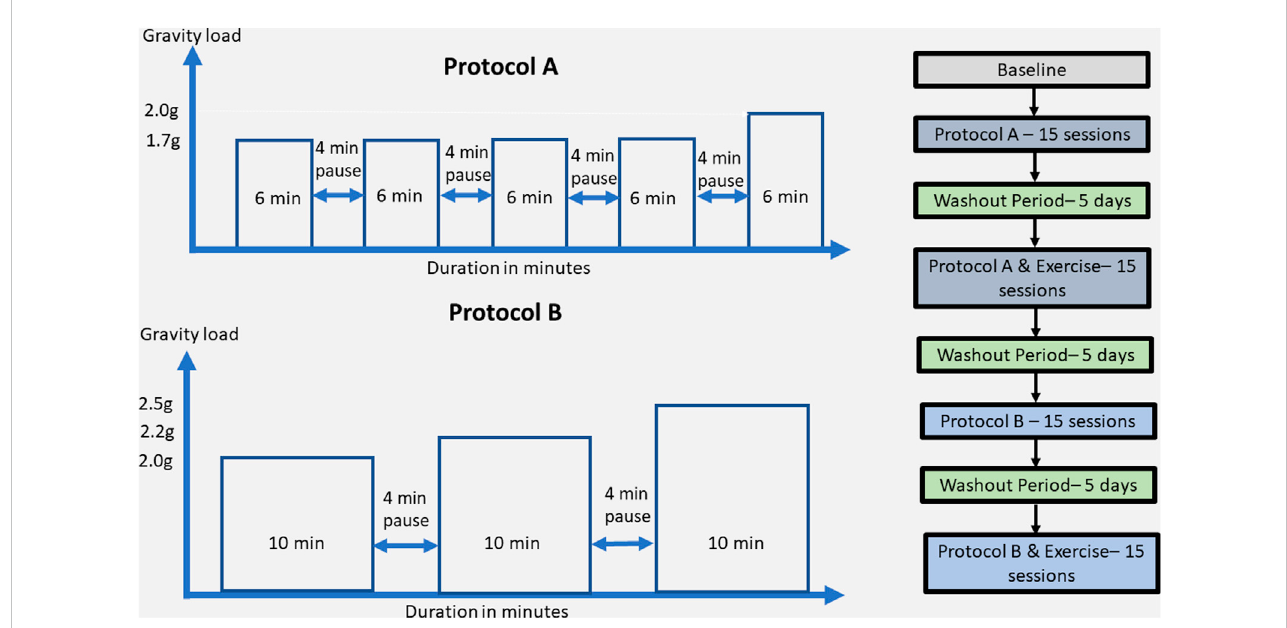
FIGURE 1 Detailed description of the protocol A and B training components on the upper left and right side, respectively. The entire rehabilitation approach in terms of protocols, exercise presence or not, wash-out periods, and number of sessions is described in the right part of the fi gure.